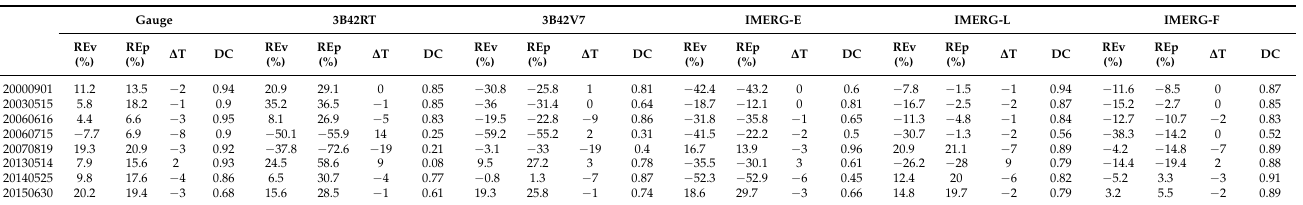
Table 3. Performance of flood event simulations at the Ganxi streamflow station using the rain-gauge and the SPPs data